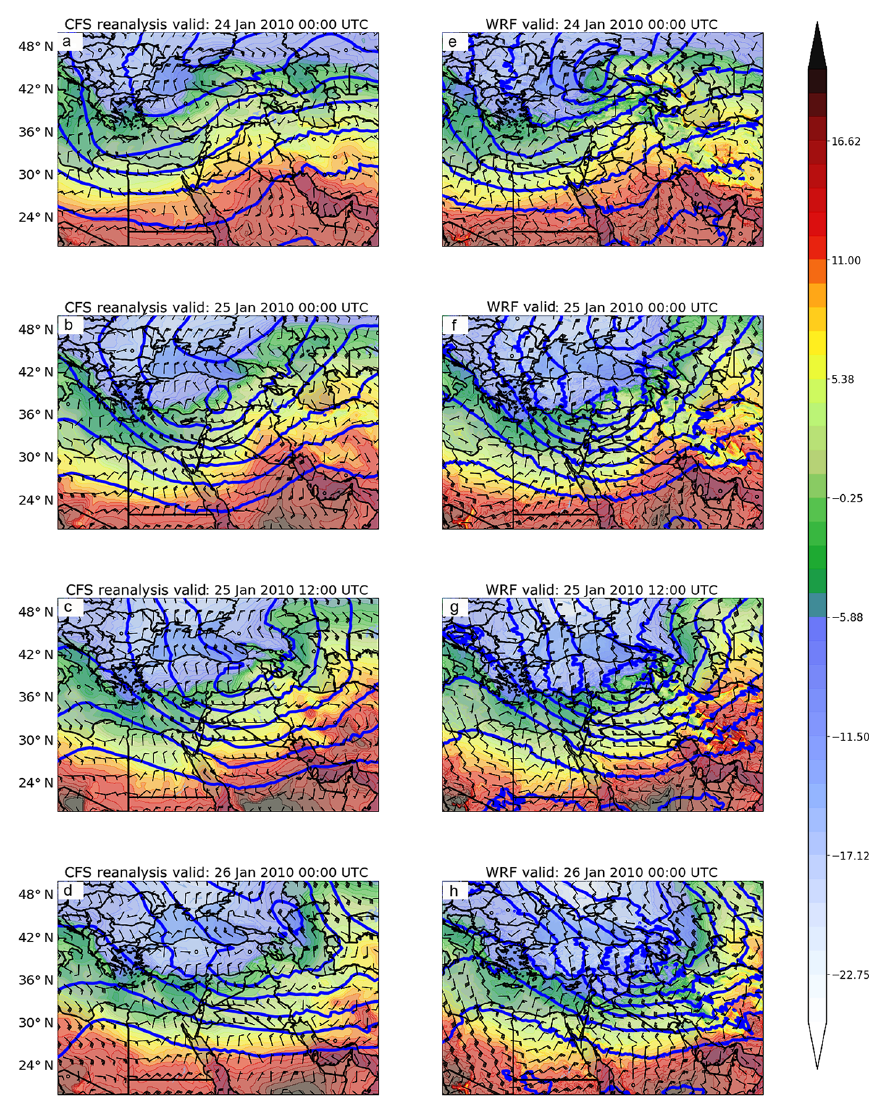
Figure 3. The synoptic environment during the time period surrounding the dust emission event. Blue lines represent 700hPa geopotential height, shading represents 850hPa temperature, and vectors represent 925hPa winds. Panels (a) – (d) show independent CFSR data. Panels (e) – (h) show WRF-Chem modeled